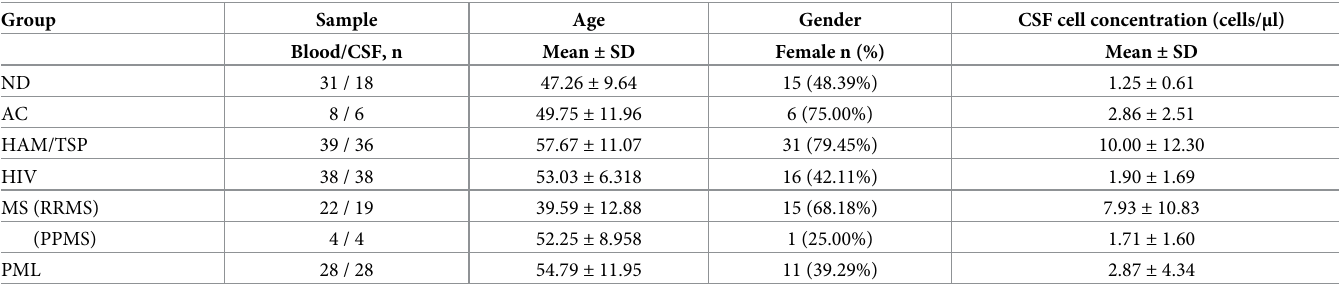
Table 1. Characteristics of subjects for flow cytometric